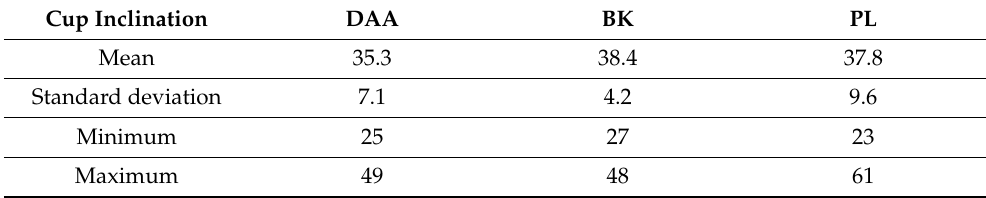
Table 4. Implant placement with the cup inclination, divided by approach and